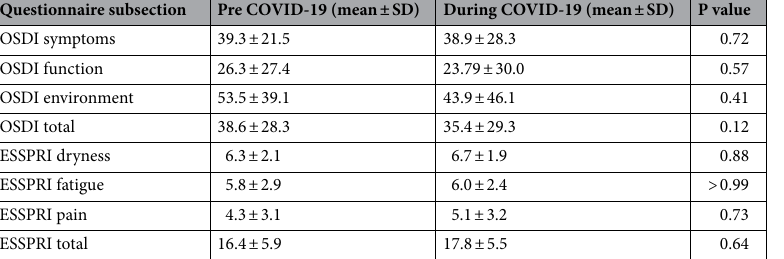
Table 2. Comparing pre COVID-19 and during COVID-19 results of the OSDI and ESSPRI subscales and overall scores (Wilcoxon test). ESSPRI, EULAR Sjögren’s Syndrome Patient Reported Index; OSDI, Ocular Surface Disease